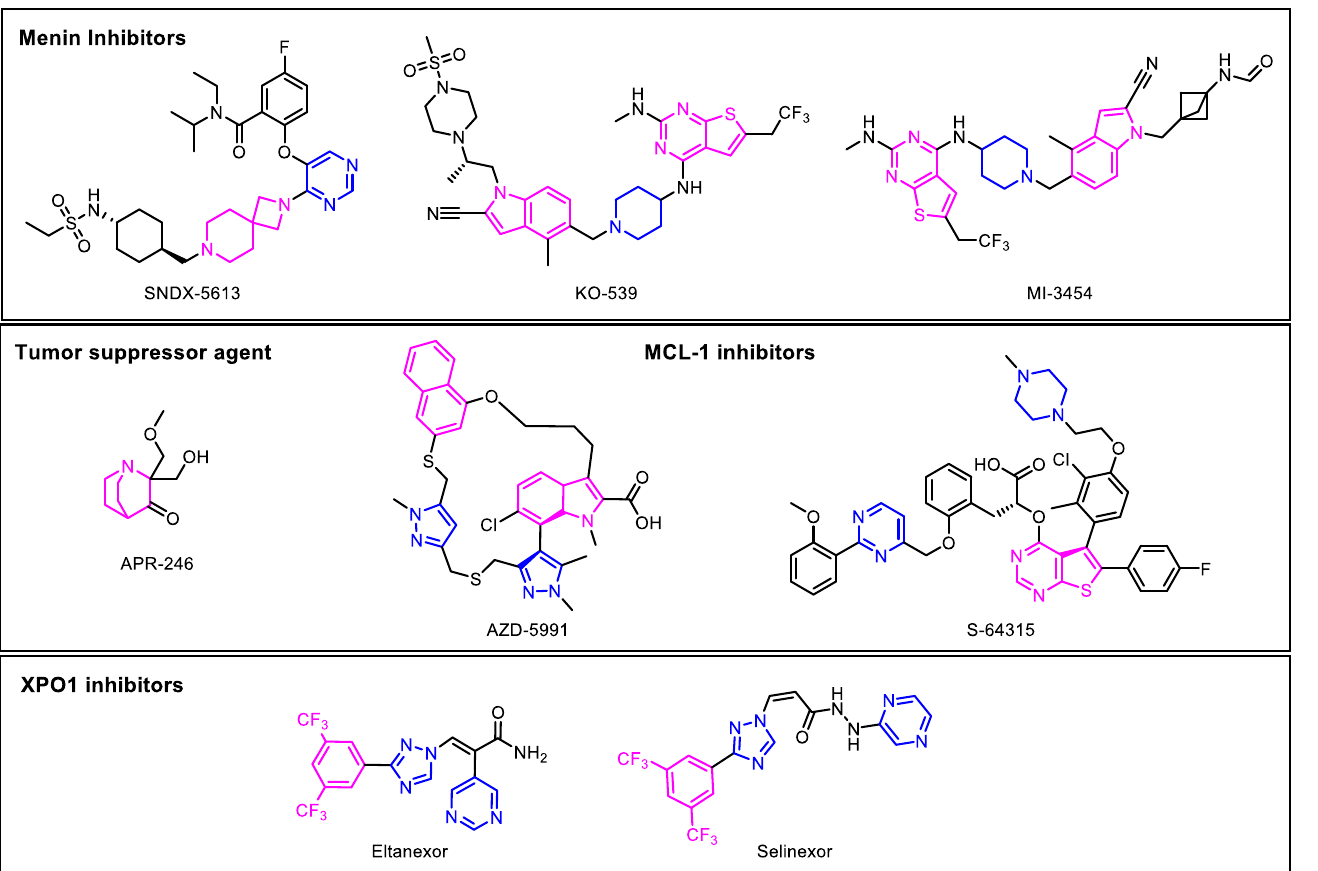
Figure 3. Novel targeted therapies in development for acute myeloid leukemia (AML). The figure shows the novel targeted therapies discussed in this review that are in development for treating AML. These include menin inhibitors, tumor suppressor agents, MCL-1 inhibitors, and XPO1 inhib- itors that have recently been used for other hematologic malignancies, but have not been approved for AML. Abbreviations: MCL-1: myeloid cell leukemia 1; XPO1: exportin-1.